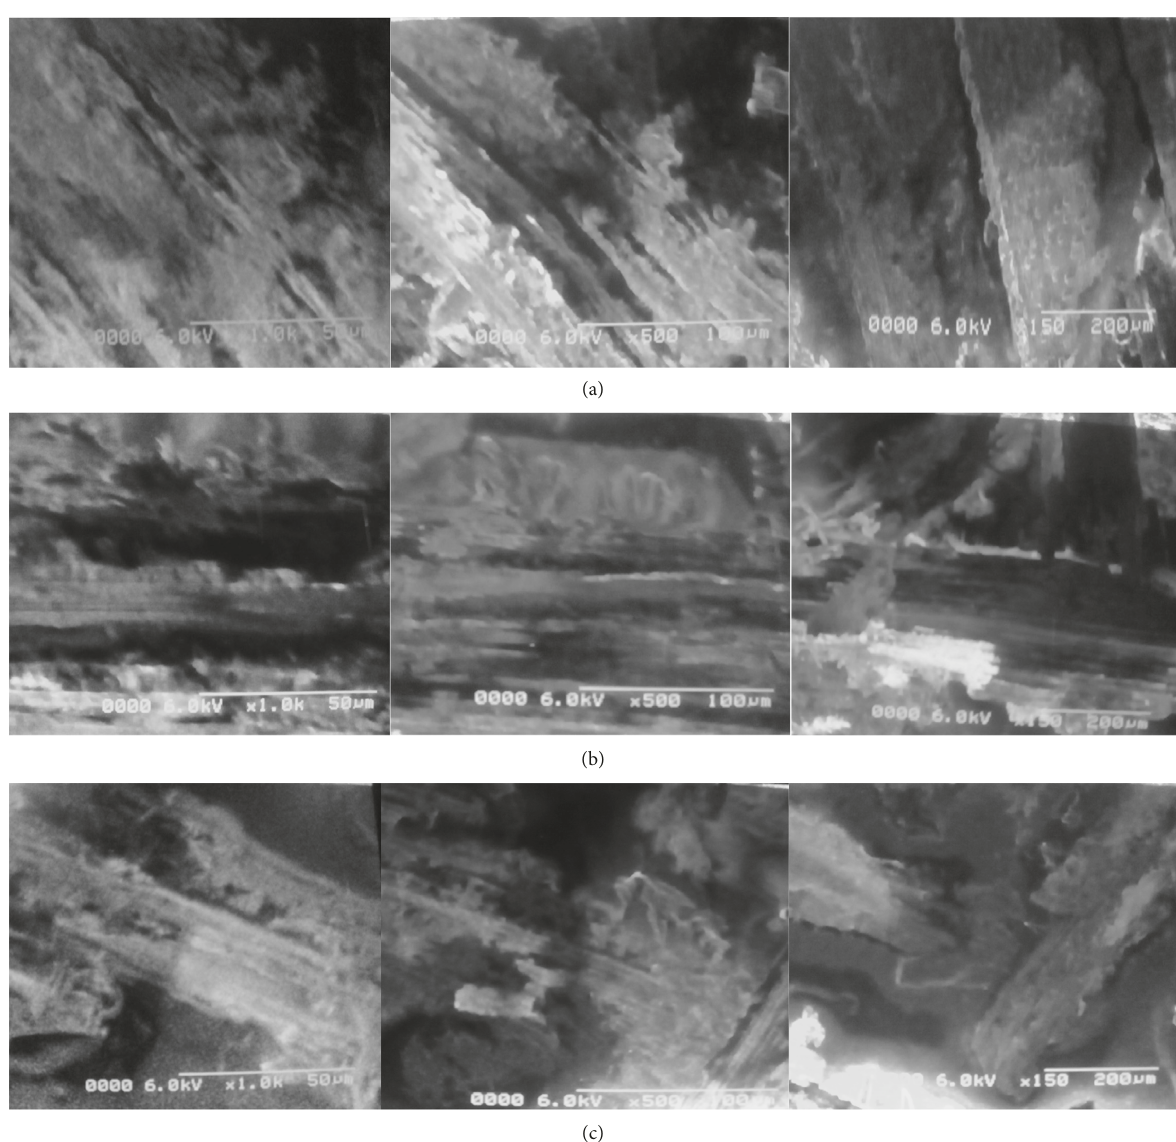
Figure 2: (a) SEM image of raw Saccharum arundinaceum at three different resolutions. (b) SEM image of base-treated Saccharum Table 1: Identified functional groups present in Saccharum arundinaceum by FTIR spectroscopy. Possible functional